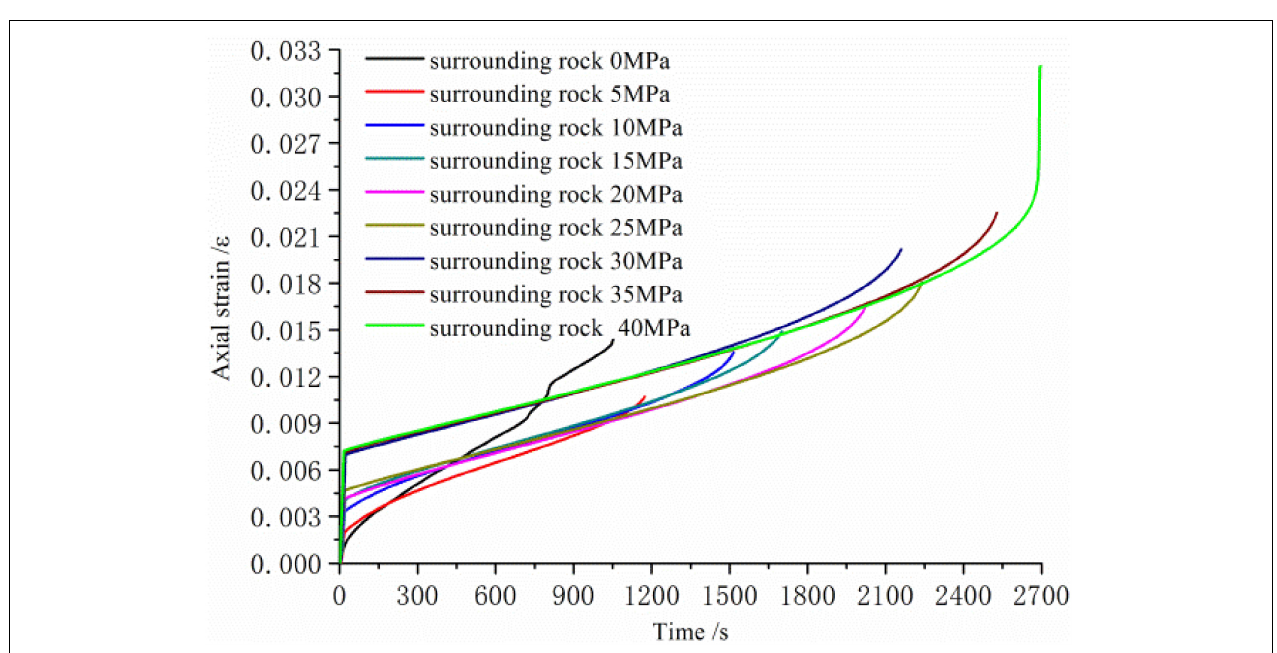
FIGURE 3 | Stress–strain curves of sandstone specimens under different confining pressures.